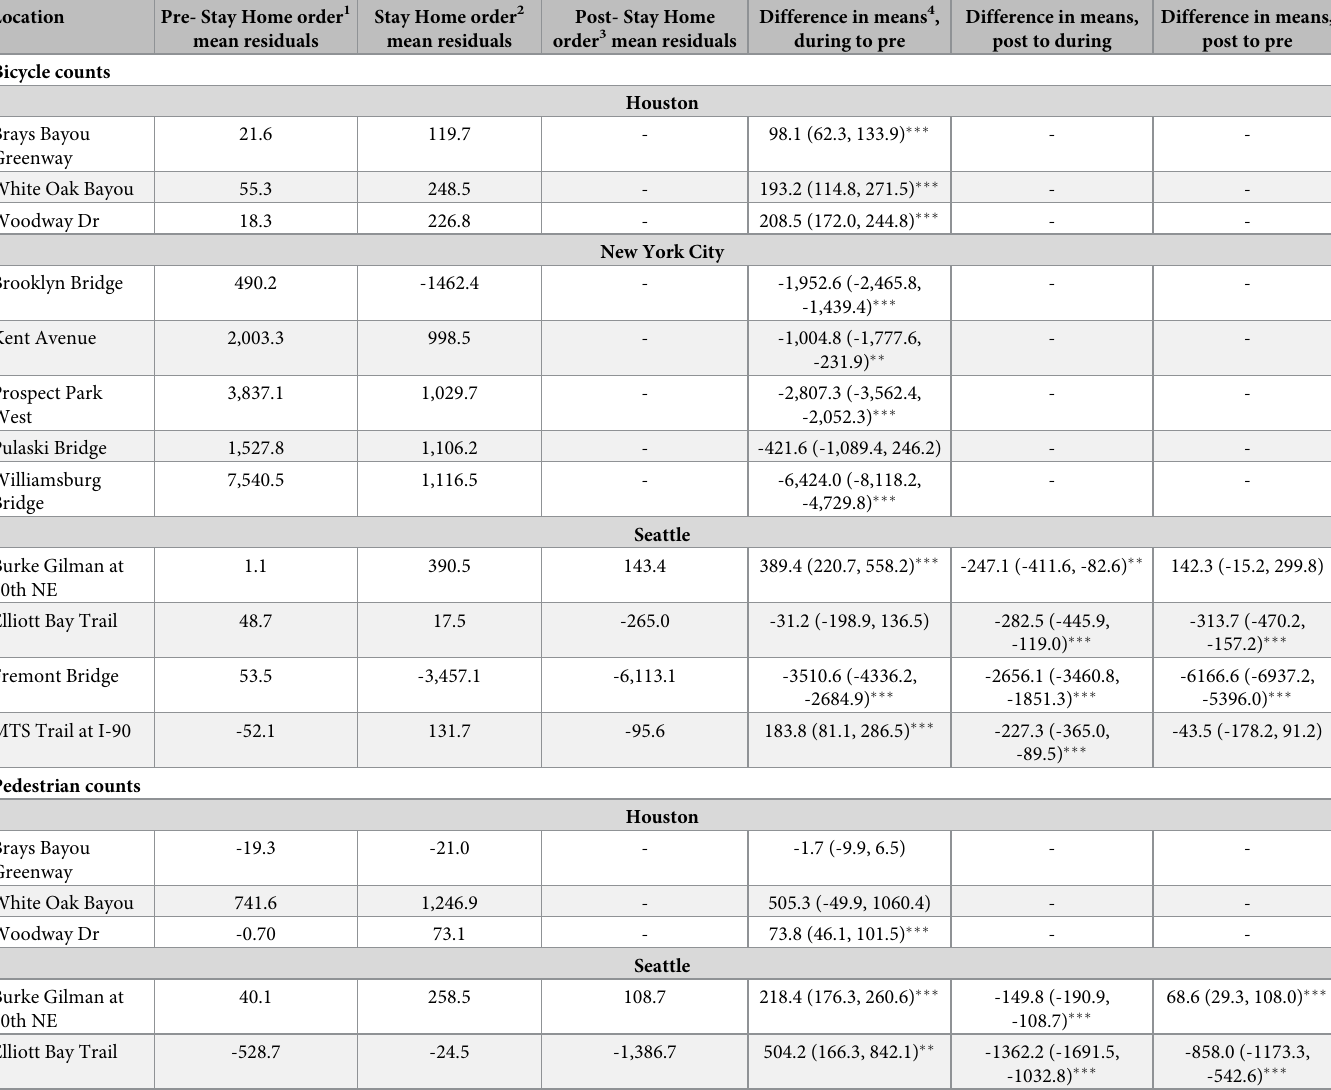
Table 2. Pre-Stay Home order, Stay Home order, and post-Stay Home order mean observed minus predicted daily bicycle or pedestrian counts by location.